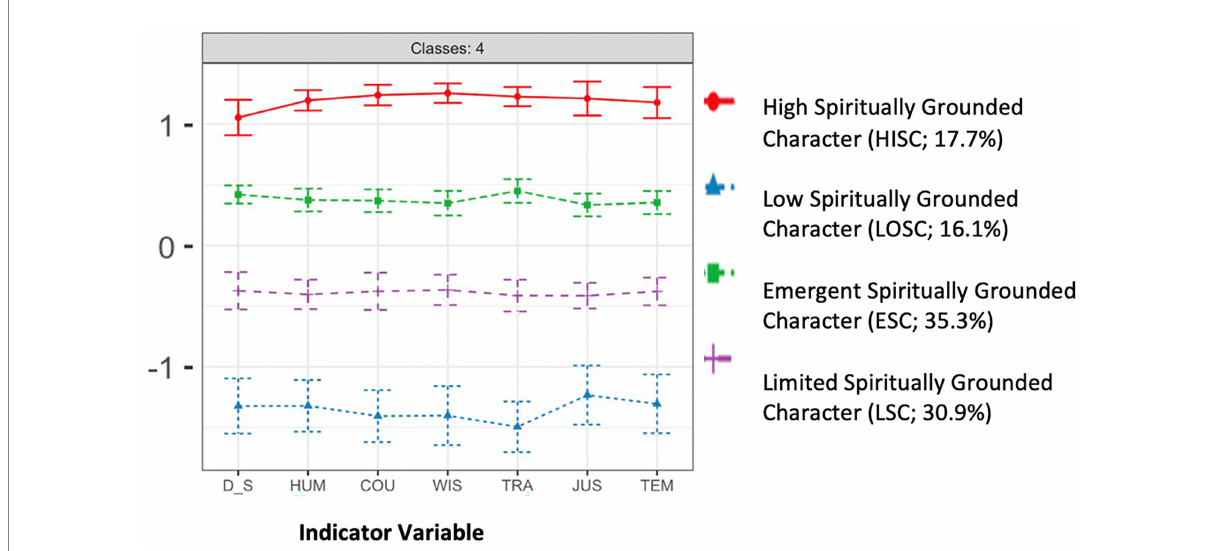
FIGURE 1 Line graph indicating the four-class solution featuring standardized mean values on the y -axis and the indicators used on the x-axis. D_S , Delaney Spirituality; HUM, Humanity; COU, Courage; WIS, Wisdom; TEM, Temperance; TRA, Transcendence; JUS, Justice. Bars represent 95% Confidence Intervals around the standardized value for a given indicator. Profile 1: High Spiritually Grounded Character (Mean Age 19%); Profile 2: Evident Spiritually Grounded Character 2: (17%); Profile 3: Limited Spiritually Grounded Character (36%); Profile 4: Low Spiritually Grounded Character